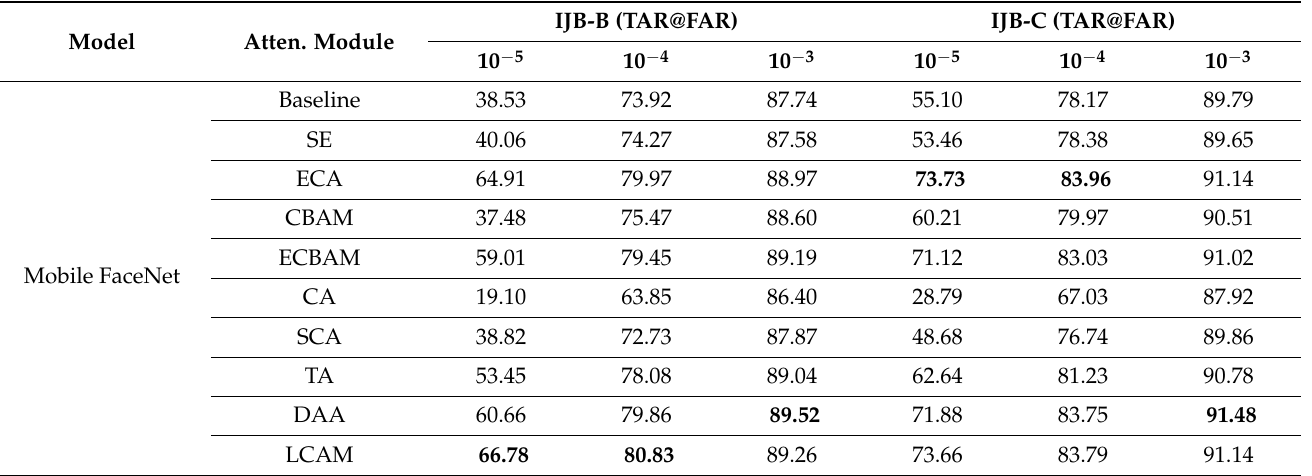
Table 10. Verification accuracy of MobileFaceNet for IJB-B and IJB-C datasets. (Bold values are the highest obtained values by the methods).